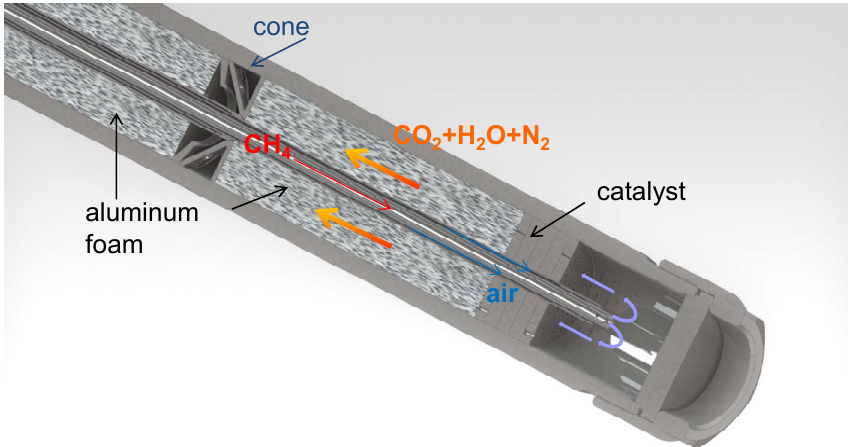
Figure 9. Design of the counter-current heat-exchange